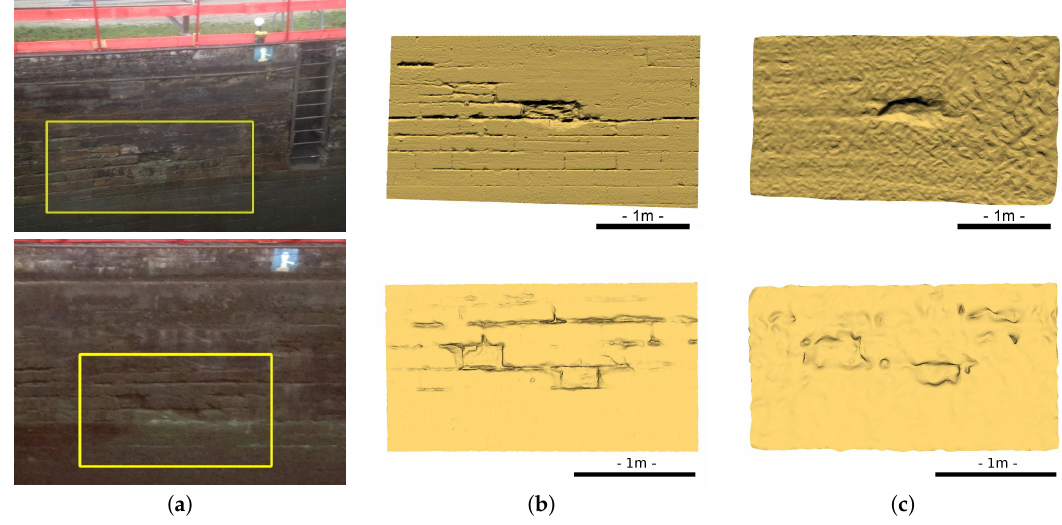
Figure 18. Details on two areas of the left lock wall: ( a ) localization; ( b ) laser model; ( c ) sonar